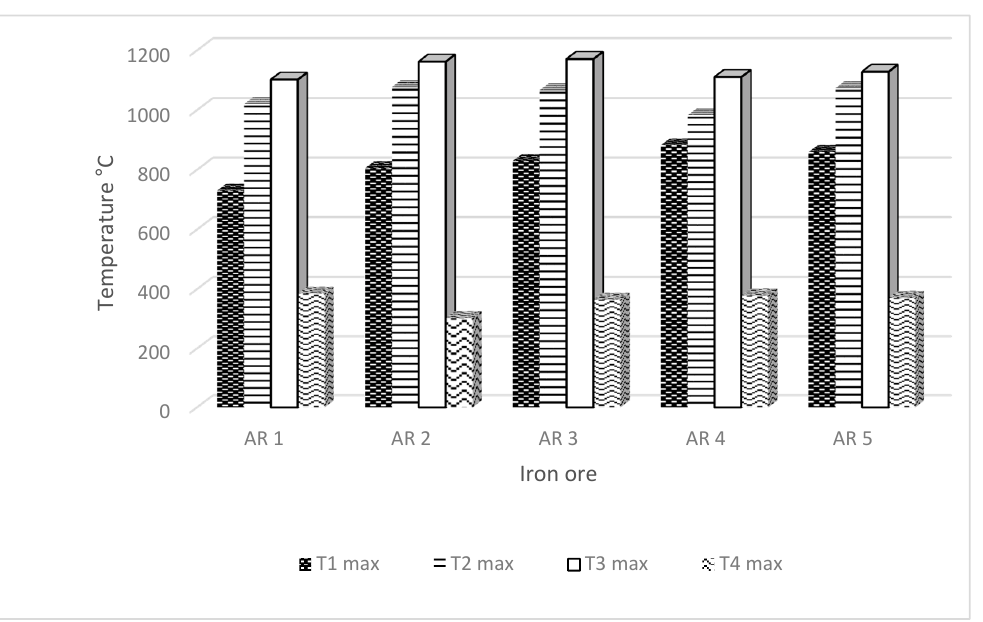
Figure 2. Temperature along the height of the agglomeration pan.